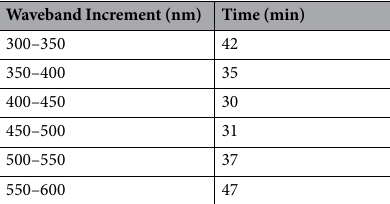
Table 3. The exposure time was adjusted accordingly to ensure each fish received 35 kJ/m 2 of light. Each waveband region was calibrated and the time was adjusted to ensure the same dose was given. The adjusted times are presented in